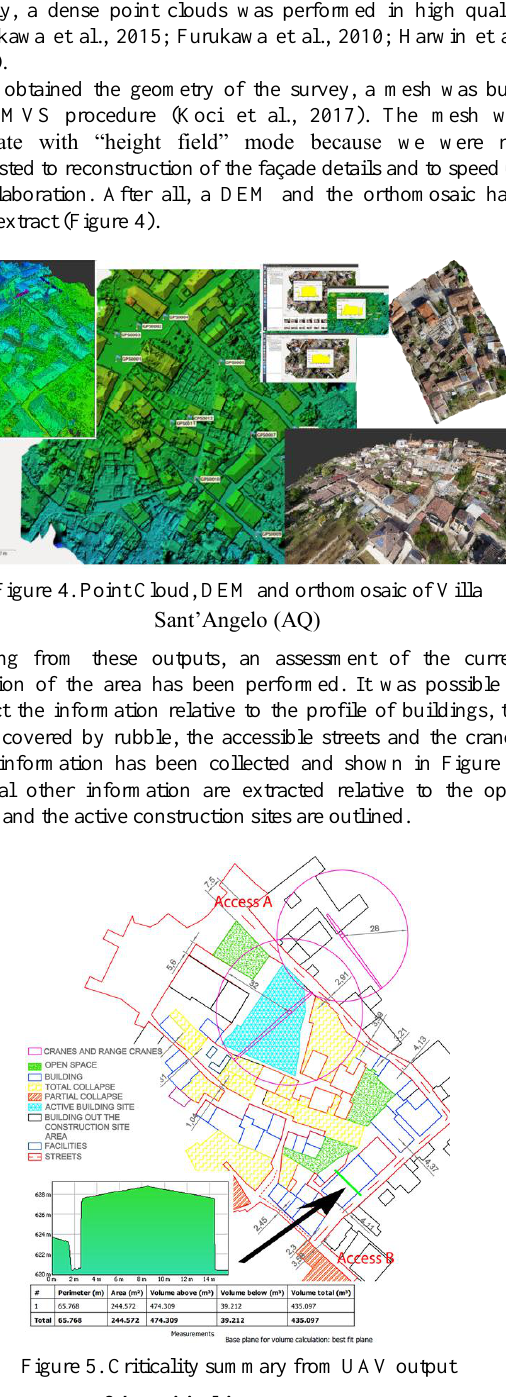
Figure 7. Each autonomous area is equipped with independent welfare facilities, service areas and equipment. On the right side the study of the cranes